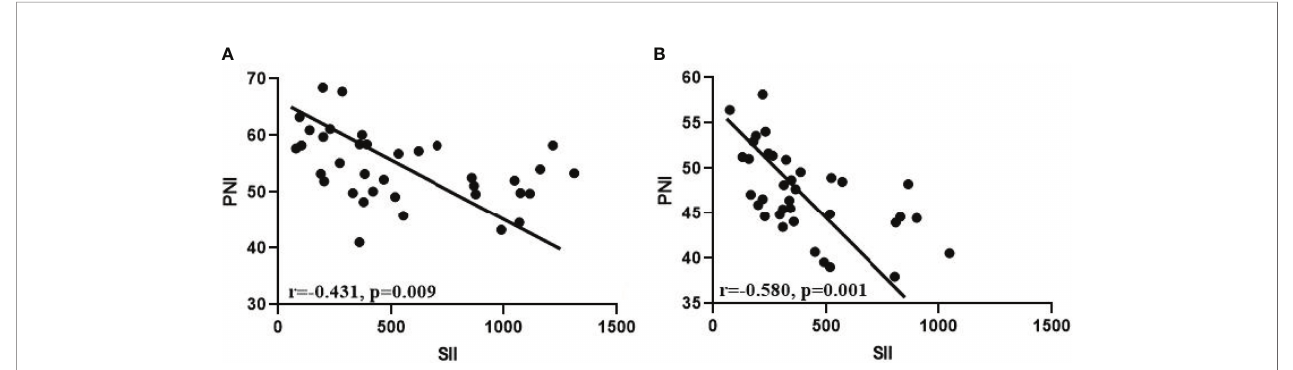
FIGURE 2 | Correlation analysis between SII and PNI. (A) Before conversion therapy; (B) After 3 cycles of conversion therapy.